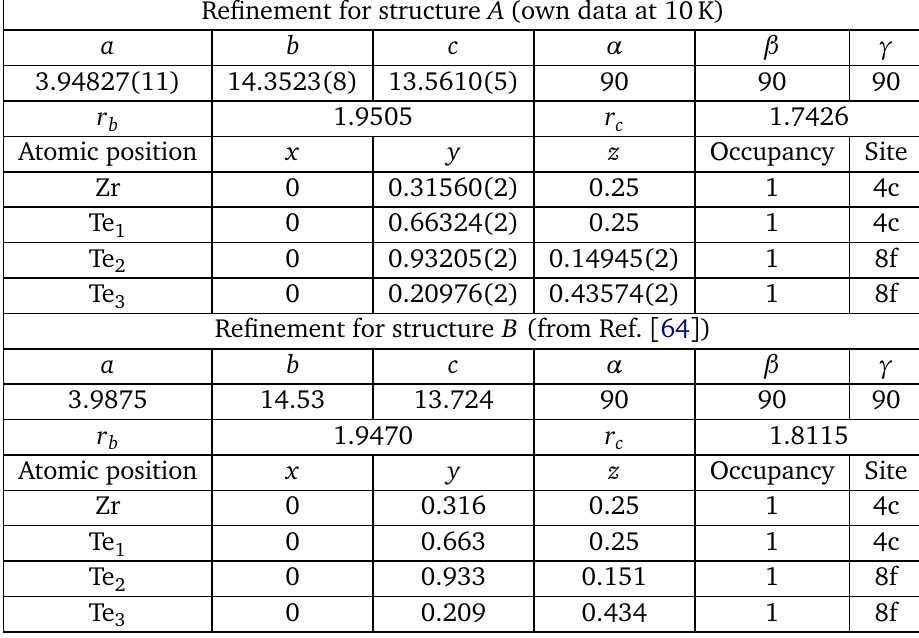
Table 1: Crystal structural parameters (Space Group Cmcm (63)). Lattice parameters and Van der Waals gaps are written in units of